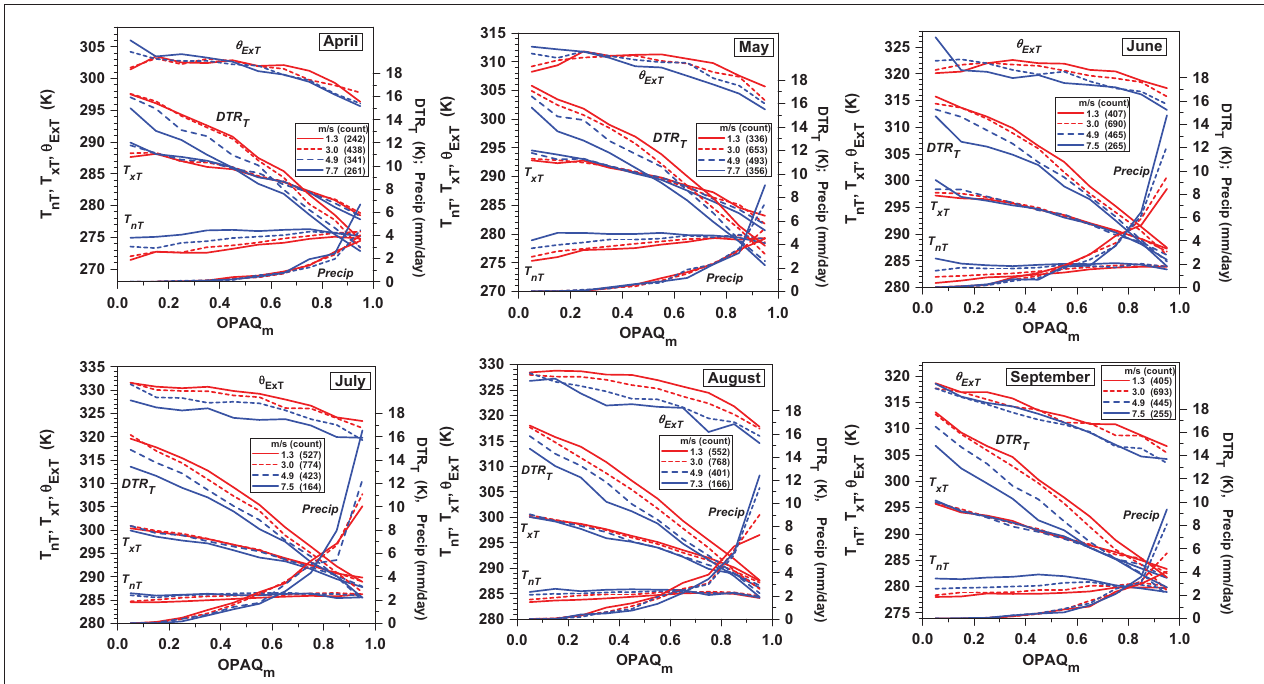
FIGURE 21 | T xt , T nt , θ Ext , DTR, and precipitation as a function of OPAQ m partitioned into four classes of daily mean windspeed, < 2, 2–4, 4–6, and > 6 m/s, for the months April to September.